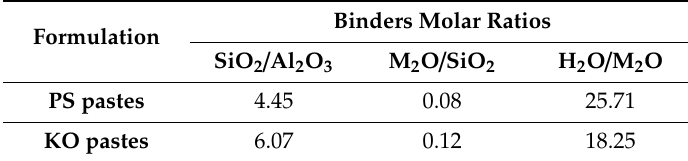
Table 2. PS and KO binders’ molar